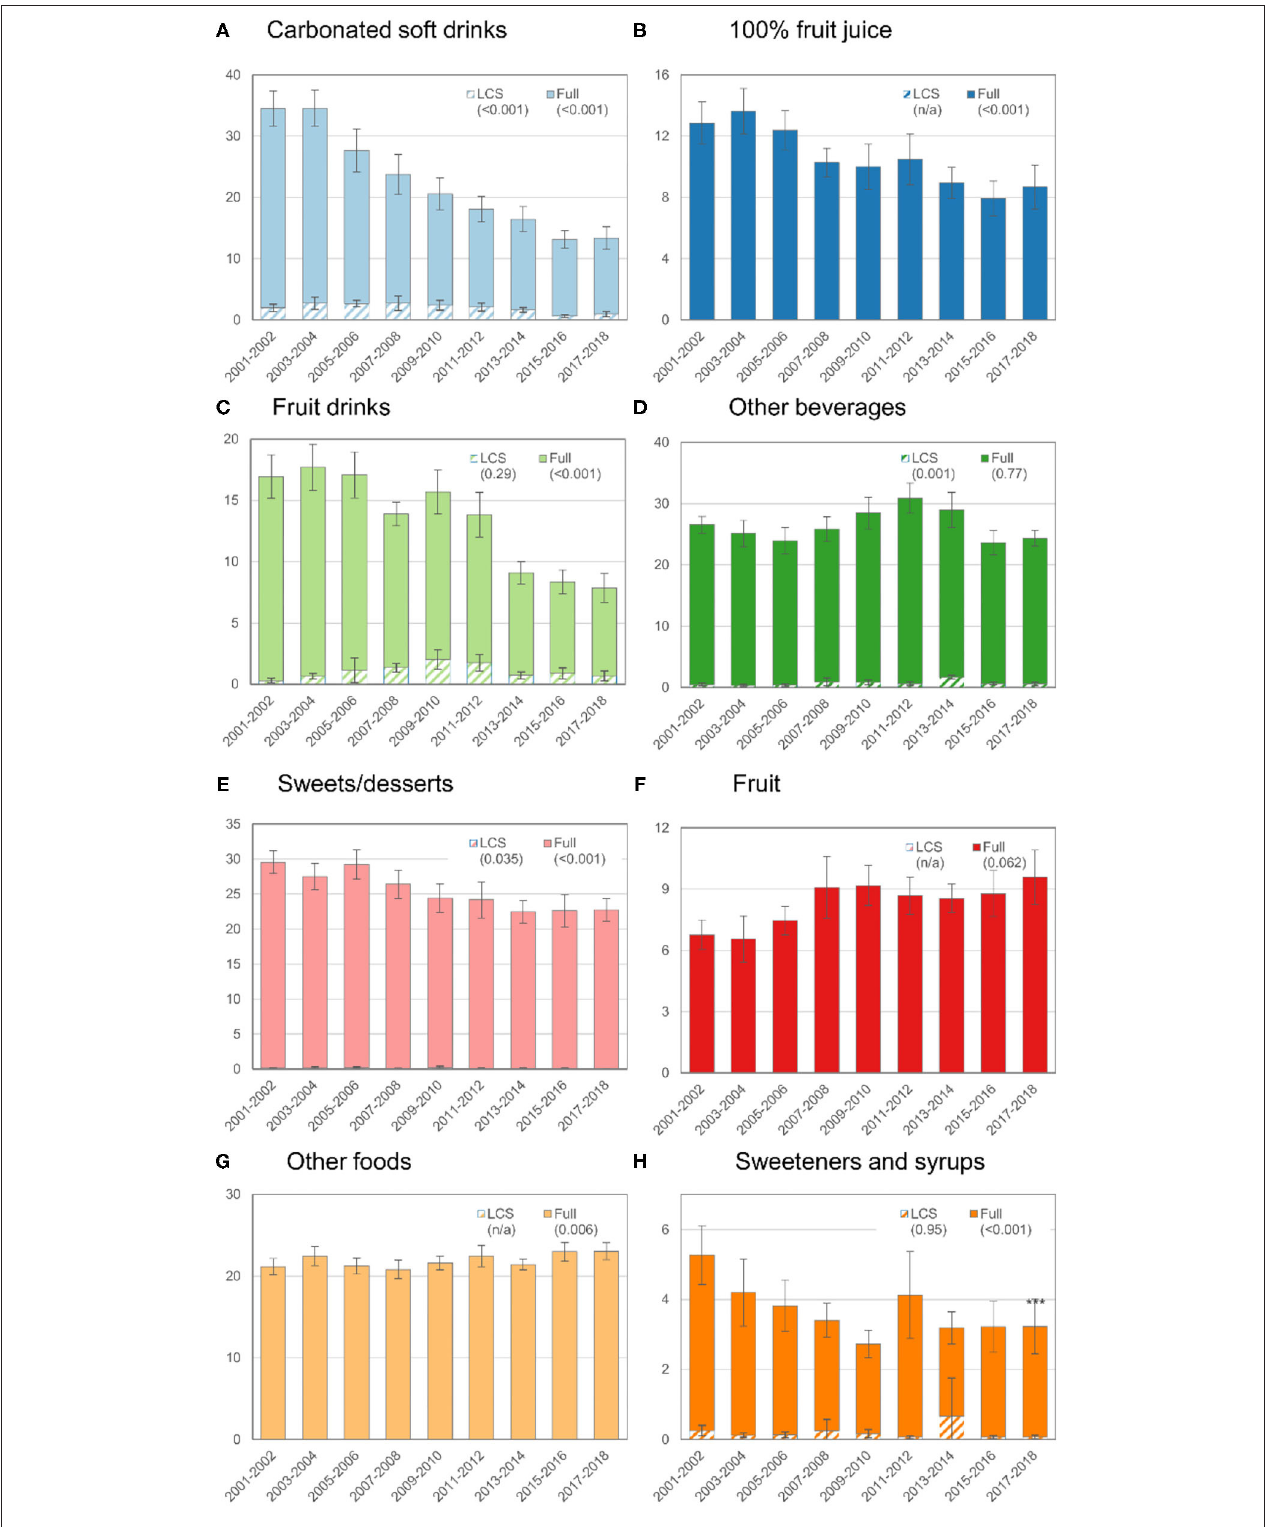
FIGURE 2 | Trends in mean ASEs by food or beverage category among children or adolescents (age 2–19 y), 2001–2018. See footnote from Figure 1 for how to interpret this figure.